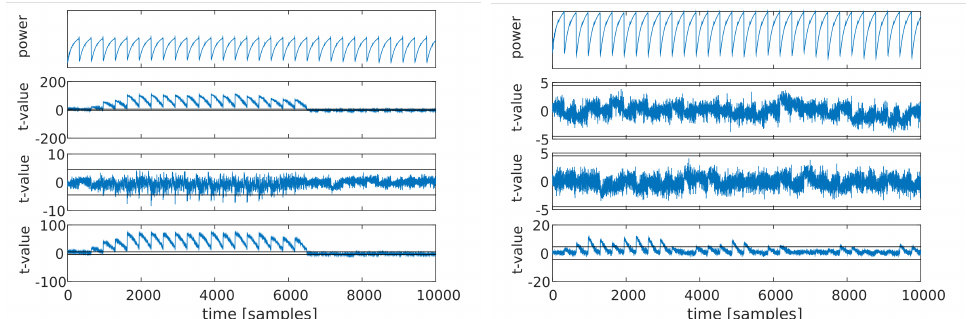
Figure 10: Non-specific t-test on second-order secure M&M AES implementation, V2. Left: PRNG off (24K traces); Right: PRNG on (100M traces). Rows (top to bottom): one